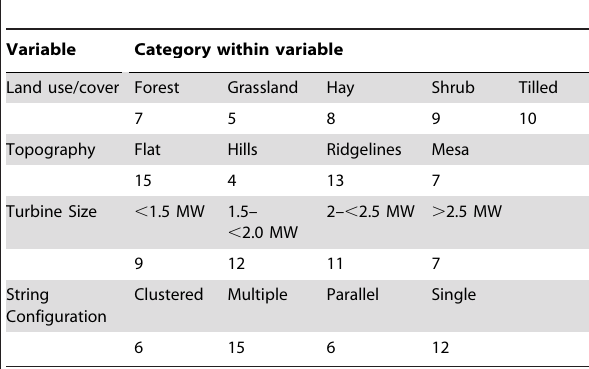
Table 2. Sample sizes associated with each categorical variable used in the